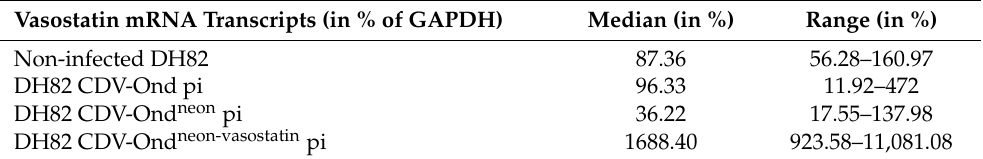
Table 5. Median and range of the number of N-terminal calreticulin (vasostatin) mRNA transcripts in % of